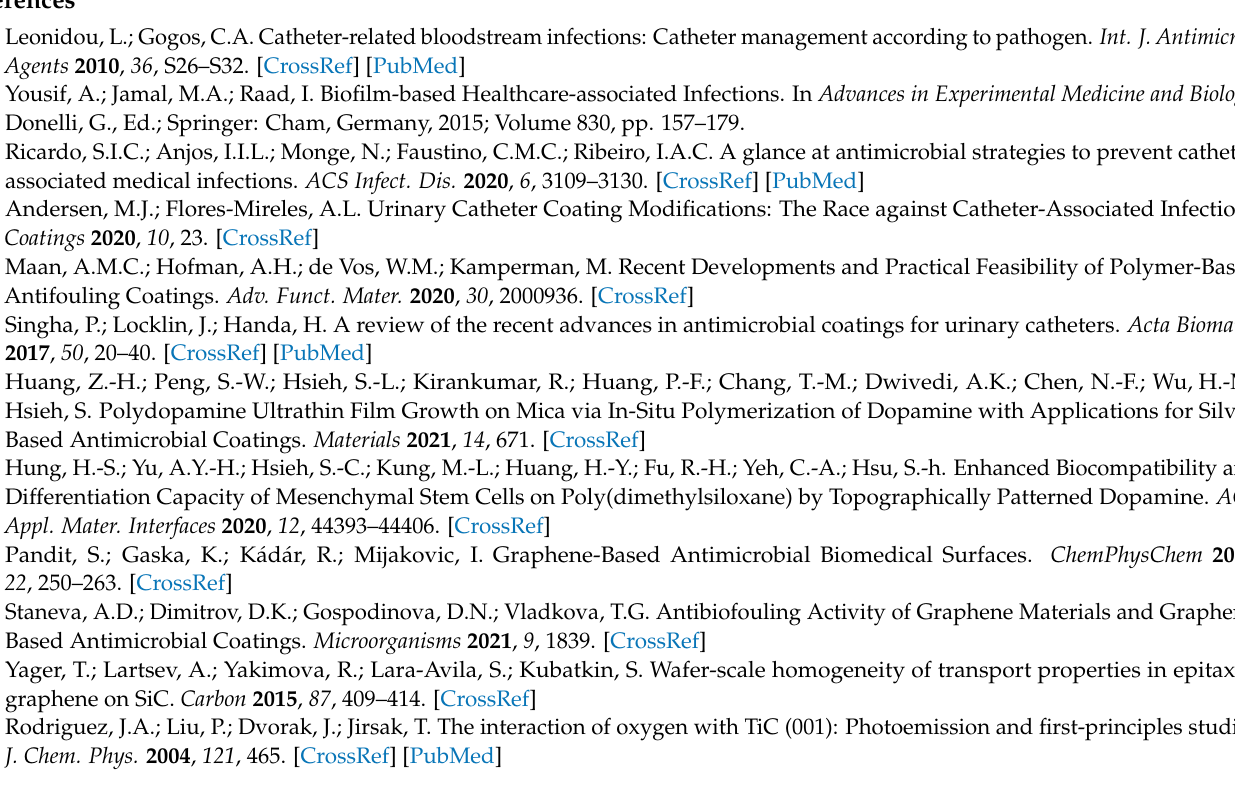
deposition; Figure S3. Images of GL-MAPLE films; Figure S4. Water drop (30 µ L) on neat PDMS slice (left) and on GL-MAPLE film (right); Figure S5. AFM of PDMS substrate; Figure S6. AFM images GL-MAPLE; Figure S7. Effect of PDMS on NIH3T3 proliferation and viability; Figure S8. GL-MAPLE slides after incubation (0–72 h) on cell